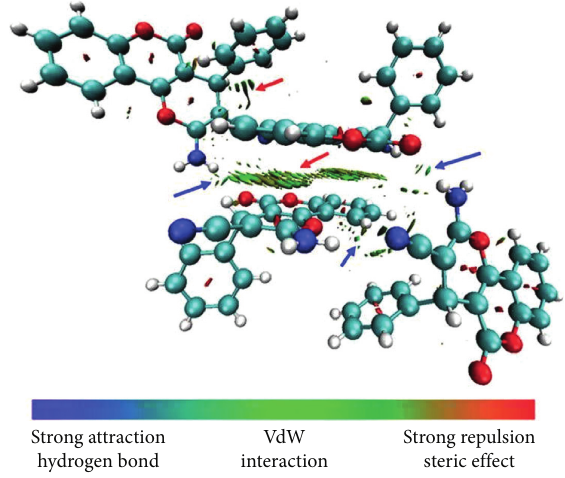
Figure 6: RDG analysis of the Chrom-D The correlation between the scaled and experimental frequencies is plotted in Figure 9. From the graph, a linearity was found between the scaled and the observed frequencies.